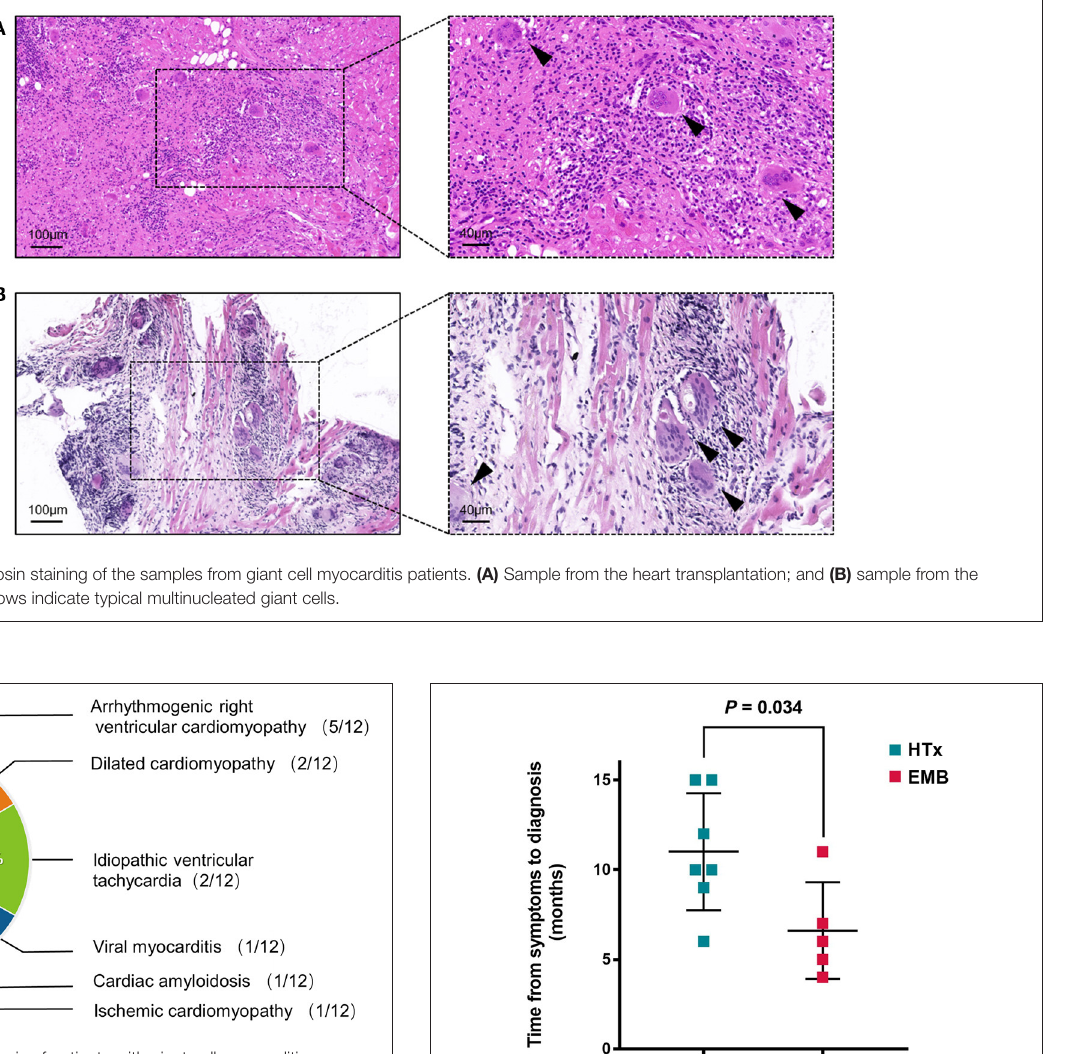
FIGURE 2 | Previous diagnosis of patients with giant cell myocarditis.